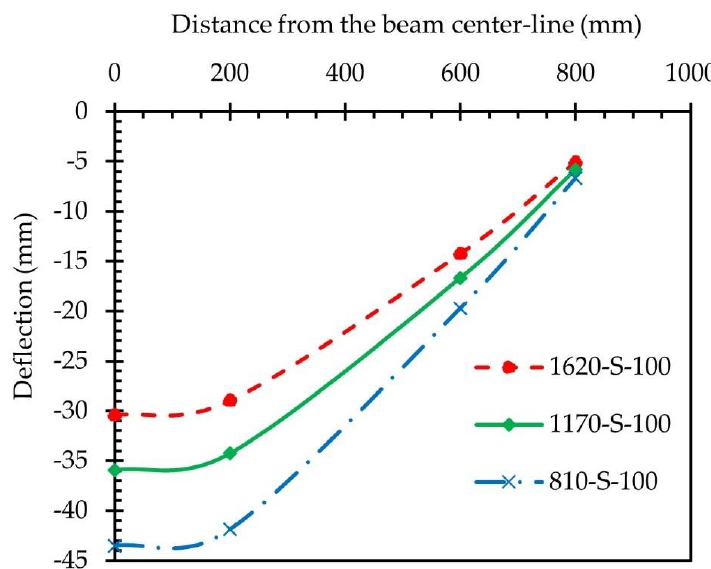
Figure 14. Deflection profiles along the spans of 1620-S-100, 1170-S-100 and 810-S-100 at 380 kN.